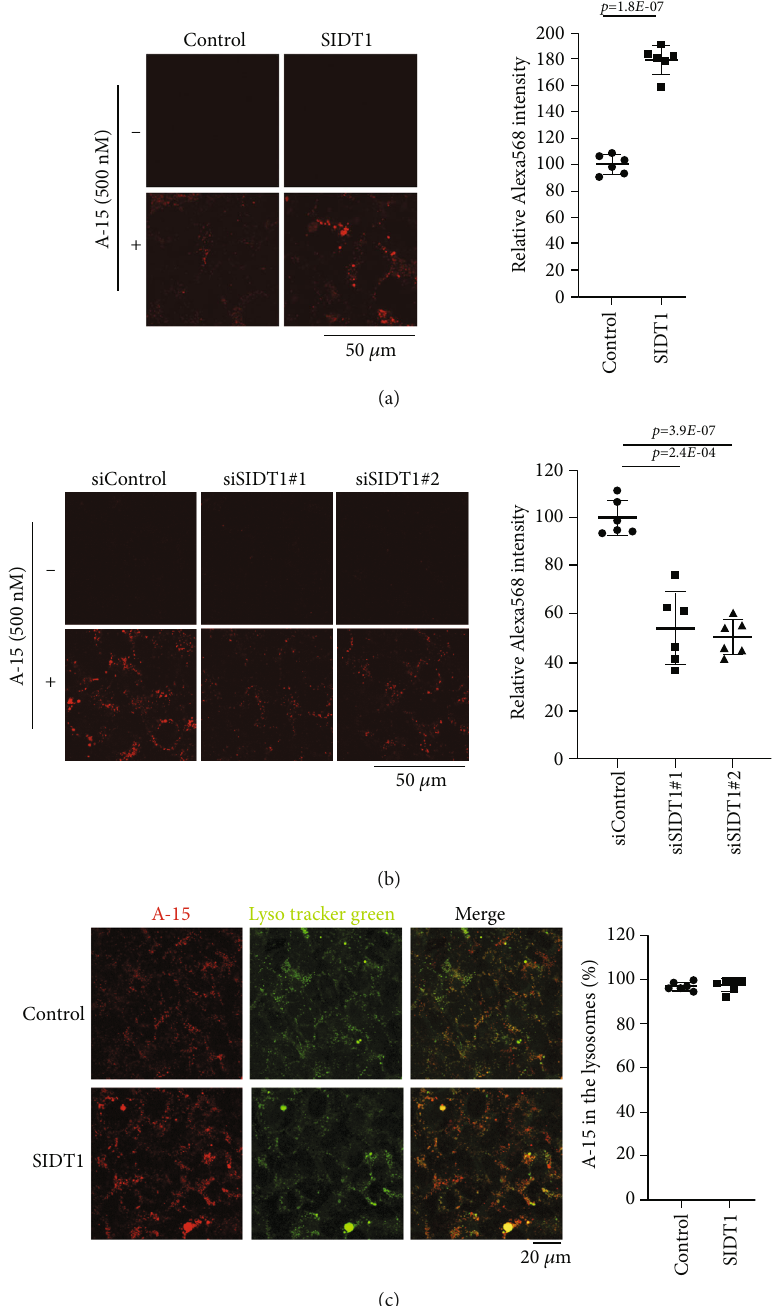
Figure 3: Microscopic analysis for the cellular uptake of naked Alexa568-labeled A-15. (a) MEFs were transfected with the empty plasmid (control) or pCI-neo-SIDT1. After the 48-hour culture, the cells were rinsed with PBS and further cultured in the absence ( – ) or presence (+) of 500nM of naked A-15 for 24 hours. After washing the cells with PBS, they were analyzed by confocal microscopy. The Alexa568 fl uorescence intensity in the SIDT1-overexpressing cells relative to that in the control cells is shown. Error bars indicate s.d. ( n = 6 ). (b) MEFs were transfected with siControl, siSIDT1#1, or siSIDT1#2. After the 72-hour culture, the cells were rinsed with PBS and further cultured in the absence ( – ) or presence (+) of 500nM of naked A-15 for 6 hours. After washing the cells with PBS, they were analyzed by confocal microscopy. The Alexa568 fl uorescence intensity in the SIDT1 knockdown cells relative to that in the control cells is shown. Error bars indicate s.d. ( n = 6 ). (c) MEFs were transfected with the empty plasmid (control) or pCI-neo-SIDT1. After the 48-hour culture, the cells were rinsed with PBS and further cultured in the presence of 500nM of naked Alexa568-labeled A-15 for 24 hours. After washing the cells with PBS, fl uorescence images from Alexa568 and LysoTracker Green were visualized using a confocal microscope. Colocalization rates were quanti fi ed with ImageJ. Error bars indicate s.d. ( n = 6